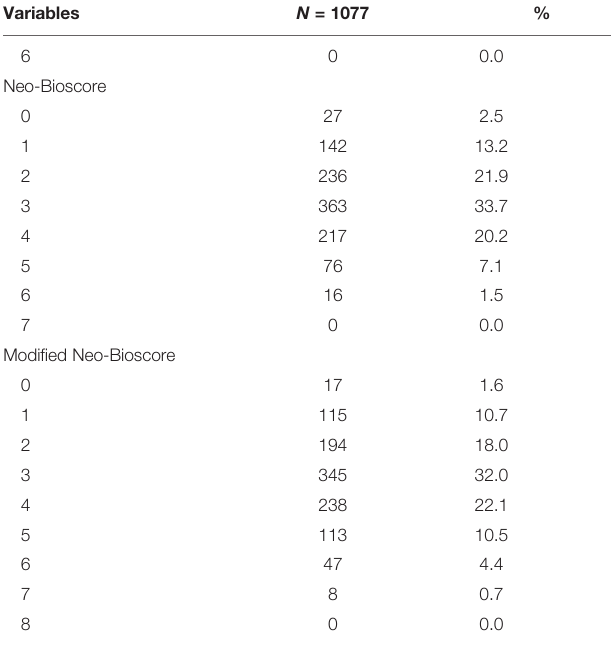
TABLE 2 | Cohort Characteristics of Patients ( N = 1,077) with Primary Breast